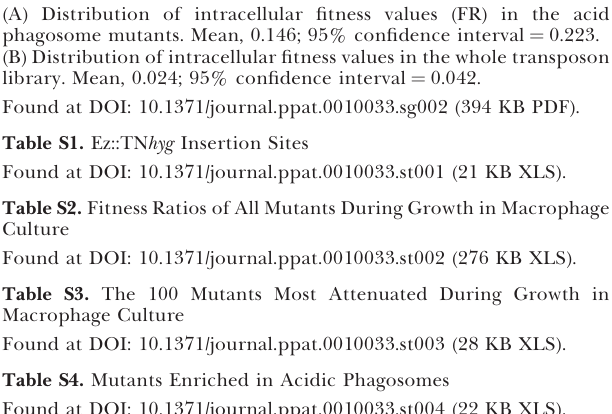
Table S1. Ez::TN hyg Insertion Sites Table S2. Fitness Ratios of All Mutants During Growth in Macrophage Culture Table S3. The 100 Mutants Most Attenuated During Growth in Macrophage Culture Table S4. Mutants Enriched in Acidic